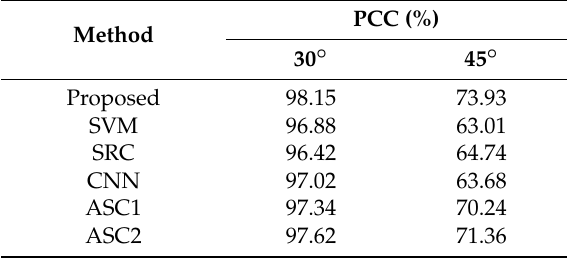
Figure 9. SAR images of 2S1 at different depression angles of ( a ) 17°; ( b ) 30°; ( c ) 45°.